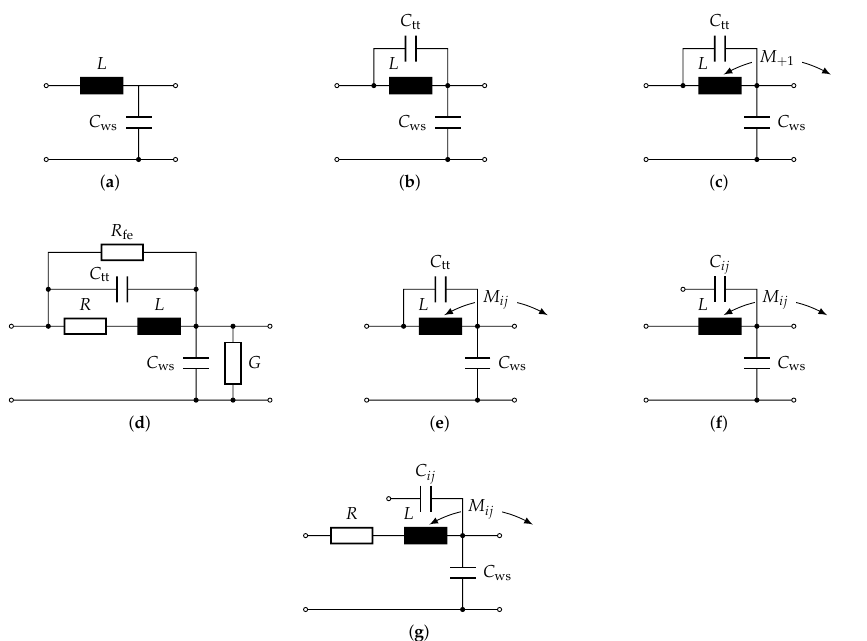
Figure 1. Chronological progression of models for the prediction of non-uniform potential distri- butions. ( a ) P. H. Thomas 1902 [3]; ( b ) K. W. Wagner 1915 [4], A. von Jouanne 1996 [10]; ( c ) R.